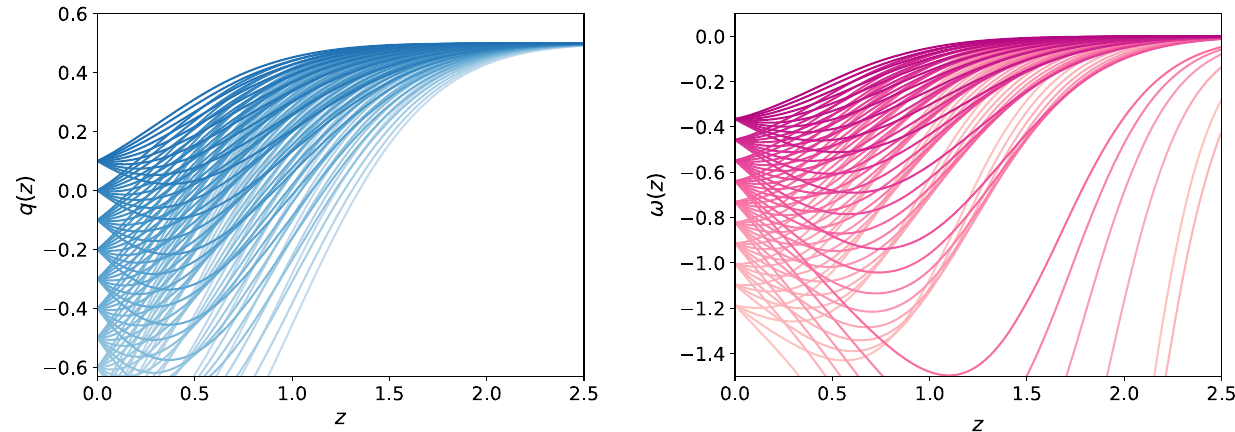
Fig. 1 Left panel: functional form of the proposed q ( z ) given by Eq. (3) for different ( q 0 , z c ) values. Notice that both an accelerated and decelerated stage at z = 0 are allowed. Right panel: functional form of ω( z ) calculated through Eq.